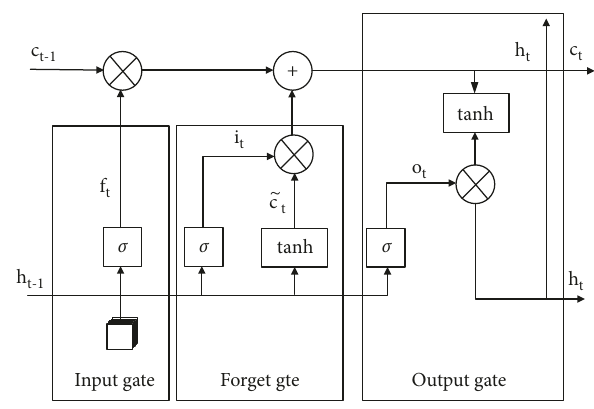
Figure 12: LSTM cell structure.